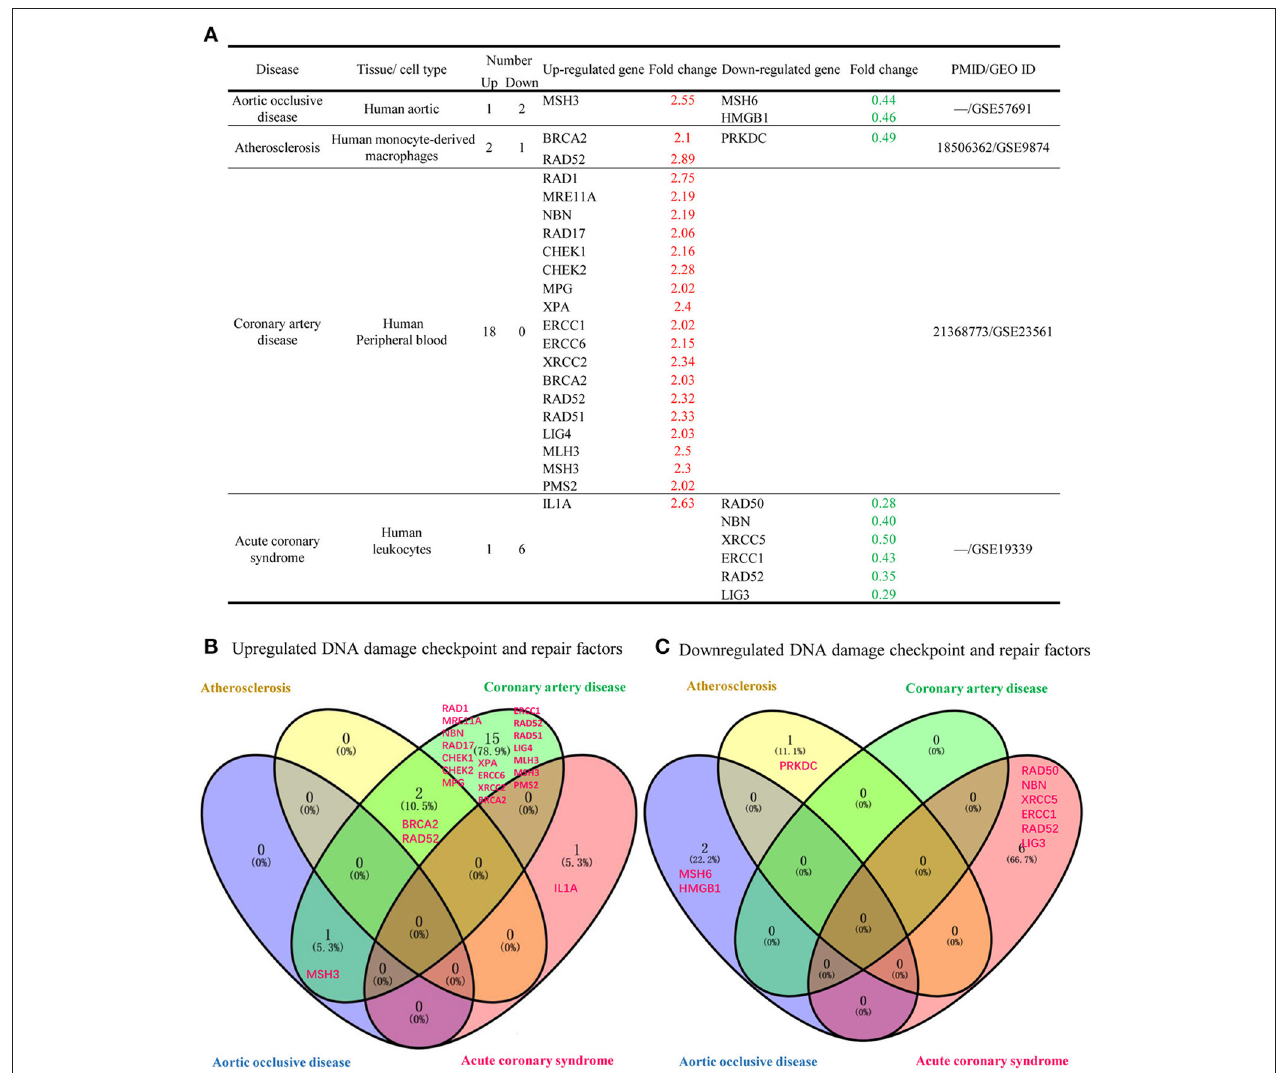
FIGURE 5 | Venn Diagram shows that significantly changed DNA damage checkpoint and repair factor in tissues among 4 different human vascular diseases are mostly disease-specific. (A) DNA damage response factors has the tendency to be more upregulated that downregulated in 4 human vascular diseases included in this study. (B) Venn diagram shows that the DNA damage checkpoint and factors that are upregulated during vascular diseases are involved in distinct signaling pathways. (C) Downregulated DNA damage checkpoint and repair factors are involved in distinct signaling pathways in different vascular